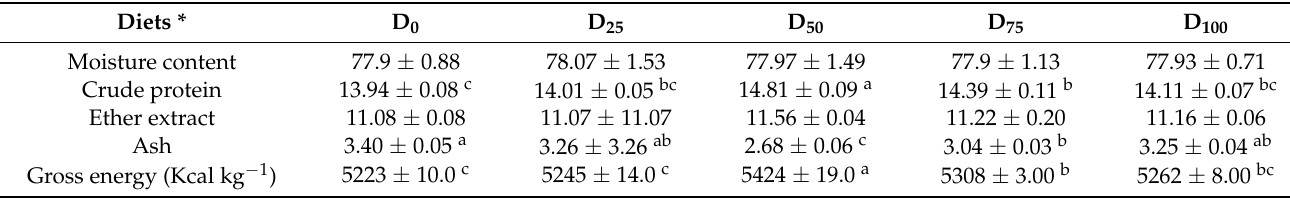
Table 6. Effect of partial or total replacement of fishmeal by amphipod meal, Gammarus pulex , on carcass composition of Mugil cephalus (% on a wet weight basis).